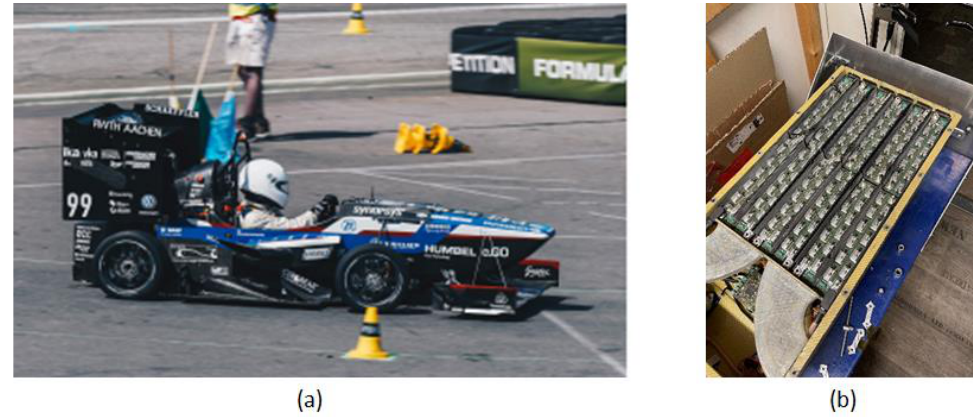
Figure 1. Pictures of the eace08 on the Hockenheim Ring ( a ) and of the battery pack ( b ).